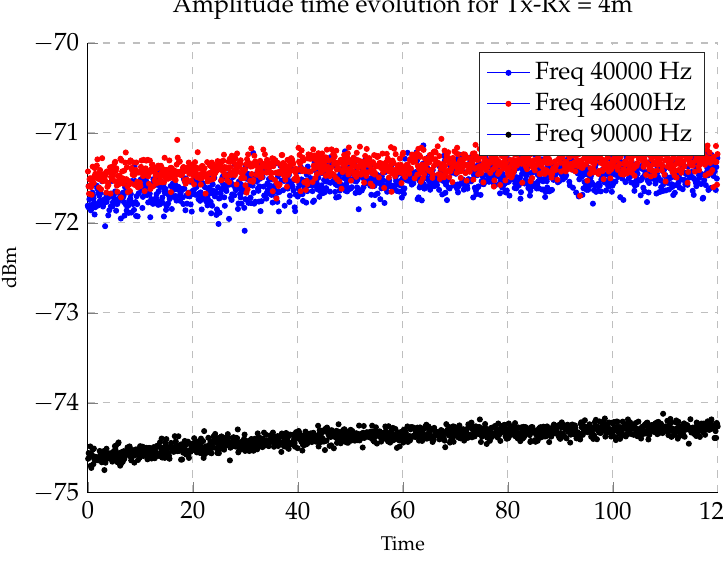
Figure 15. Amplitude time evolution during a 2 h time